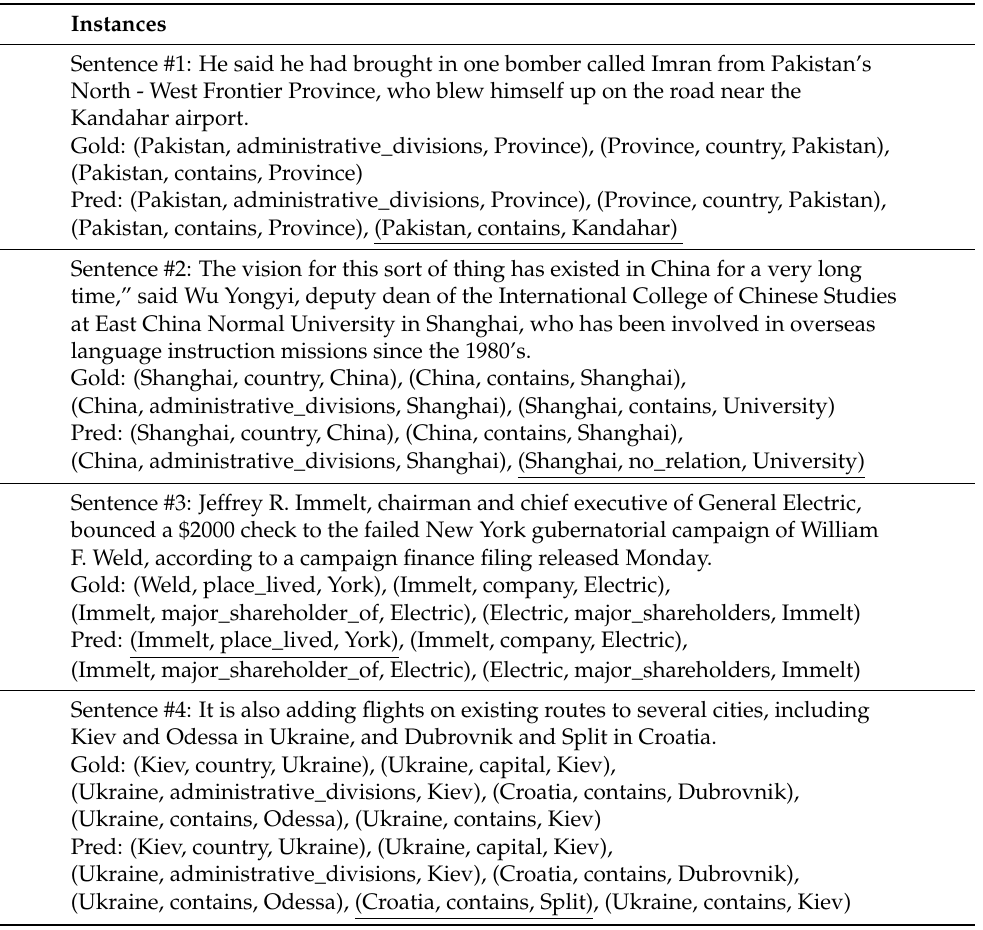
Table 7. Error analysis on different